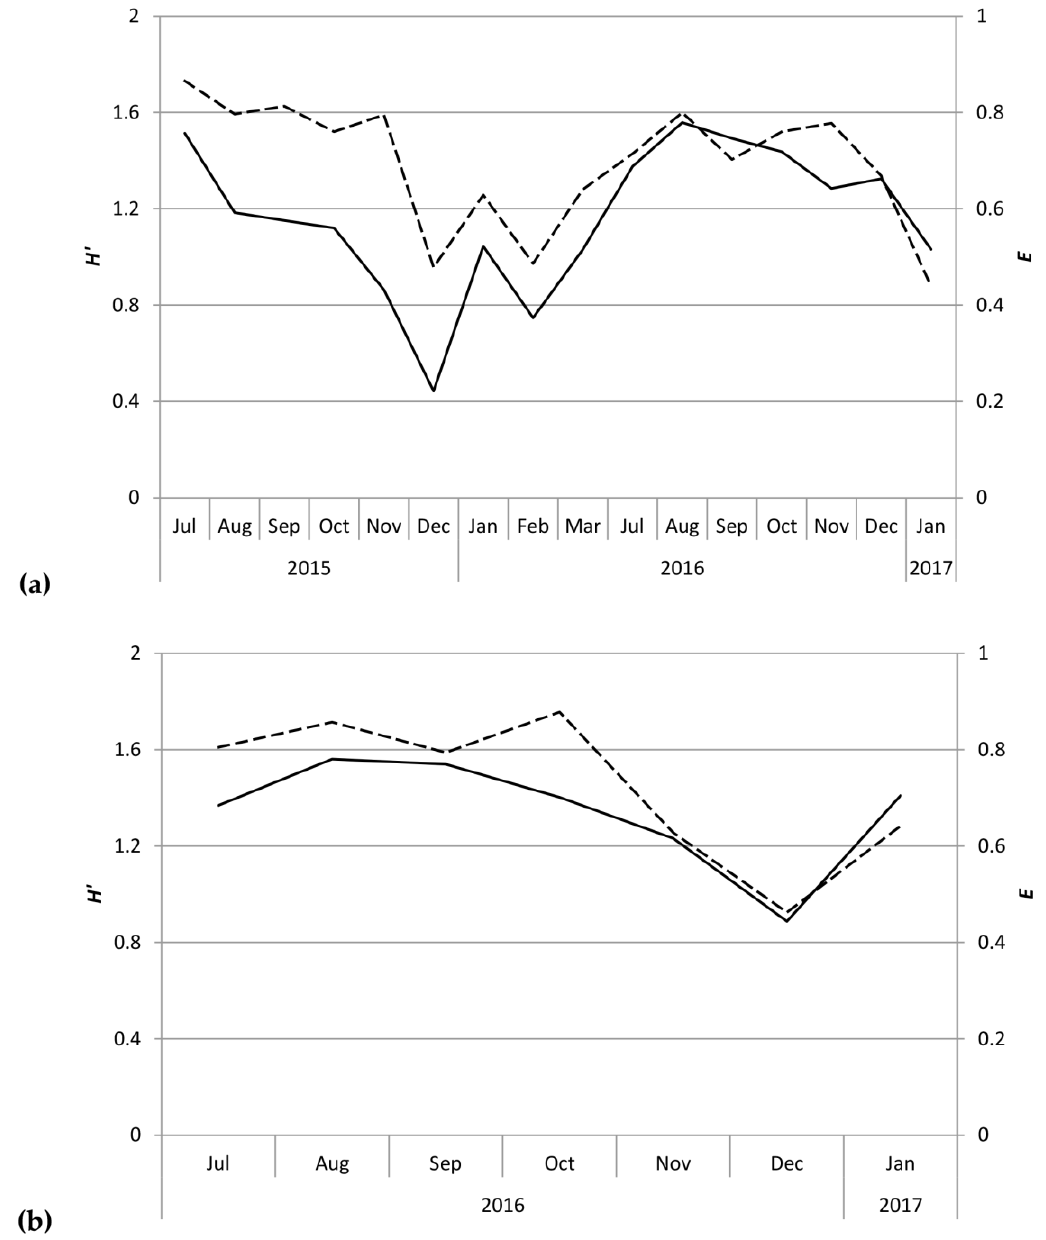
Figure 3. Shannon–Wiener diversity ( H’ = solid line) and species evenness ( E = dashed line) of the scolytine community at ( a ) the Kaua ʻ i Coffee Company and ( b ) Moloa ʻ a Bay Coffee.